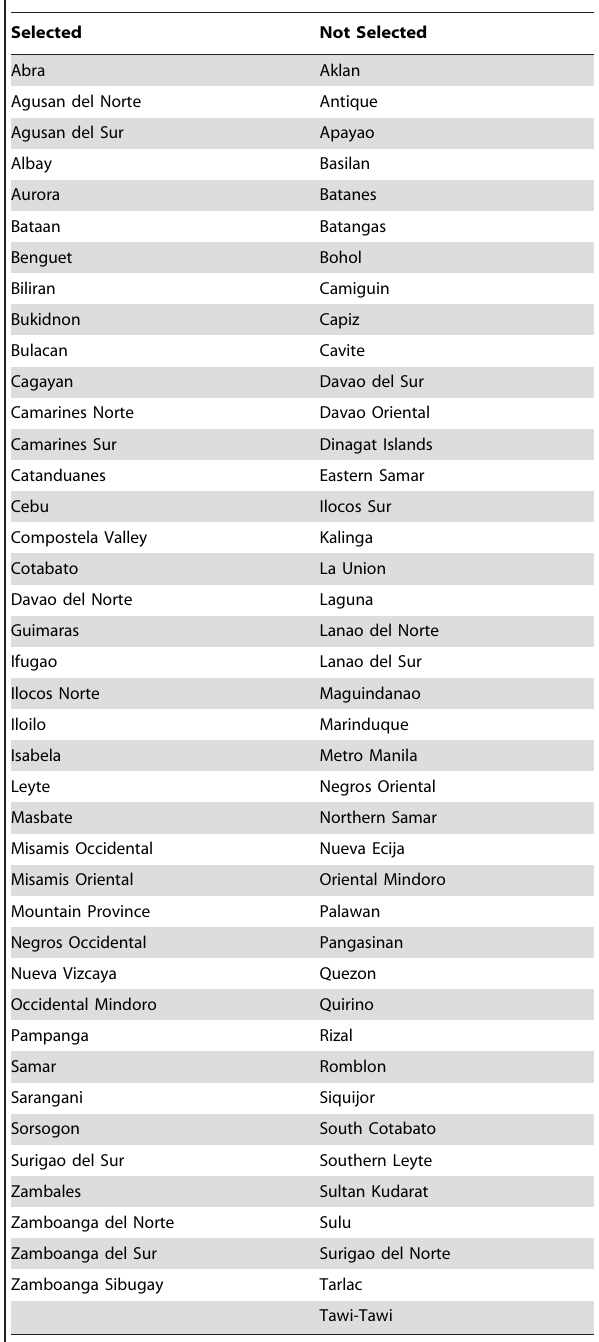
Table 2. Matched geographic information between dengue visits data and GIS file.